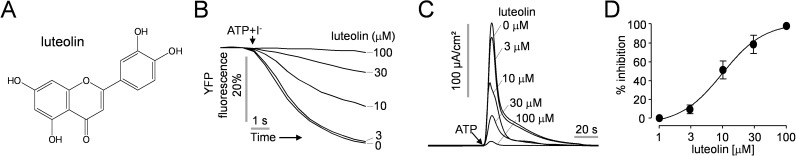
Identification of a novel inhibitor of ANO1, luteolin.A) Chemical structure of luteolin. B) ANO1 activity was measured in FRT cells expressing human ANO1 and a halide sensor YFP. ANO1 activity was inhibited by the indicated concentrations of luteolin. C) Apical membrane currents were recorded from FRT cells expressing ANO1. Representative current traces showing luteolin induced-ANO1 inhibition at the indicated concentration. ANO1 was activated by100 μM ATP. D) Summary of dose-response (mean ± S.E., n = 3–4).